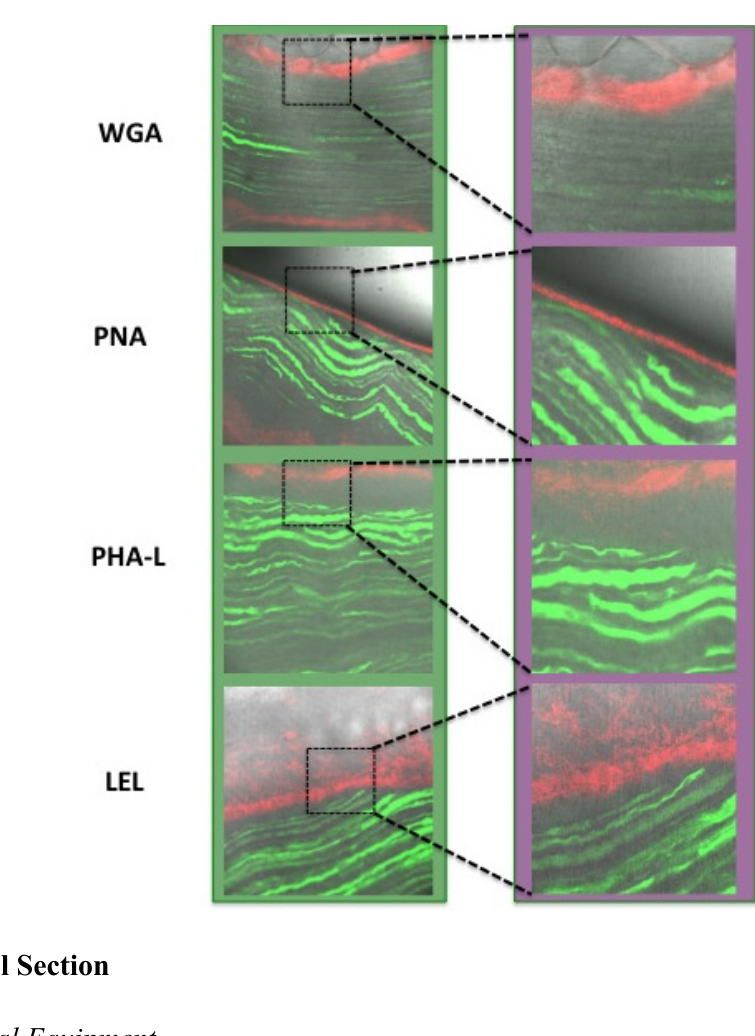
Figure 7. Ex vivo incubation. Ex vivo incubation confirmed the in vivo localization of staining. (YFP in green and Cy5 in